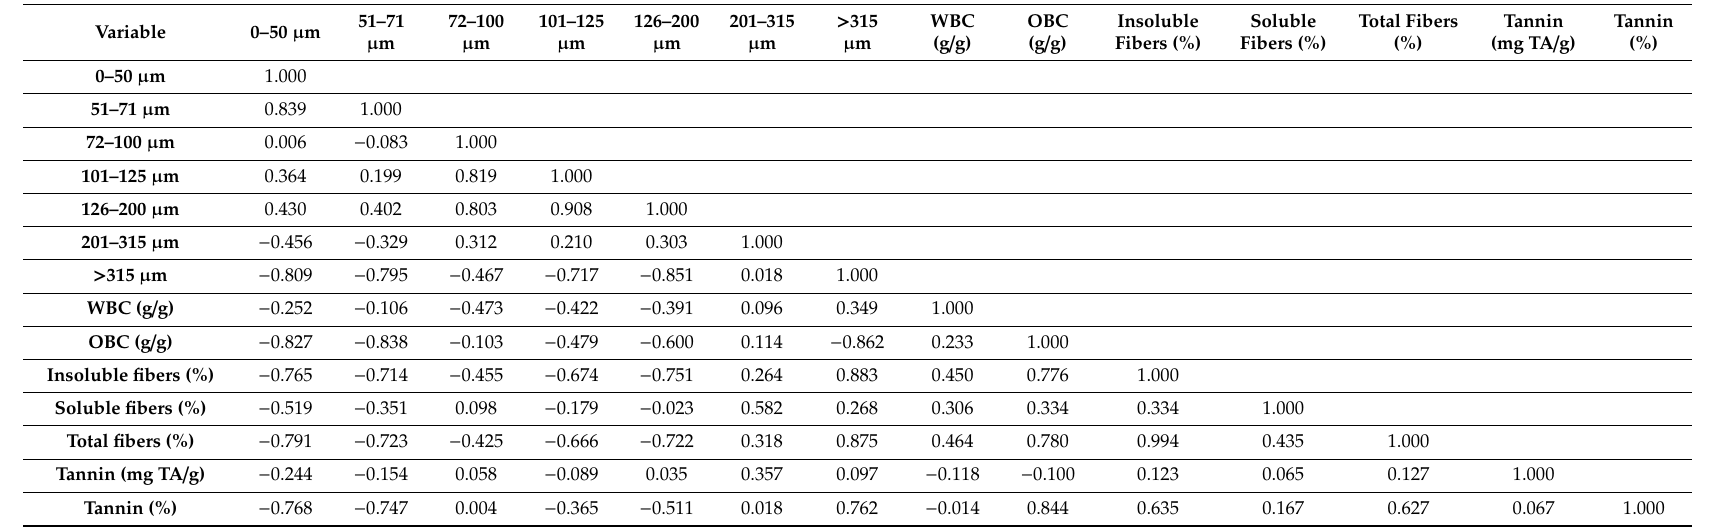
Table 4. Pearson’s coe ffi cients of